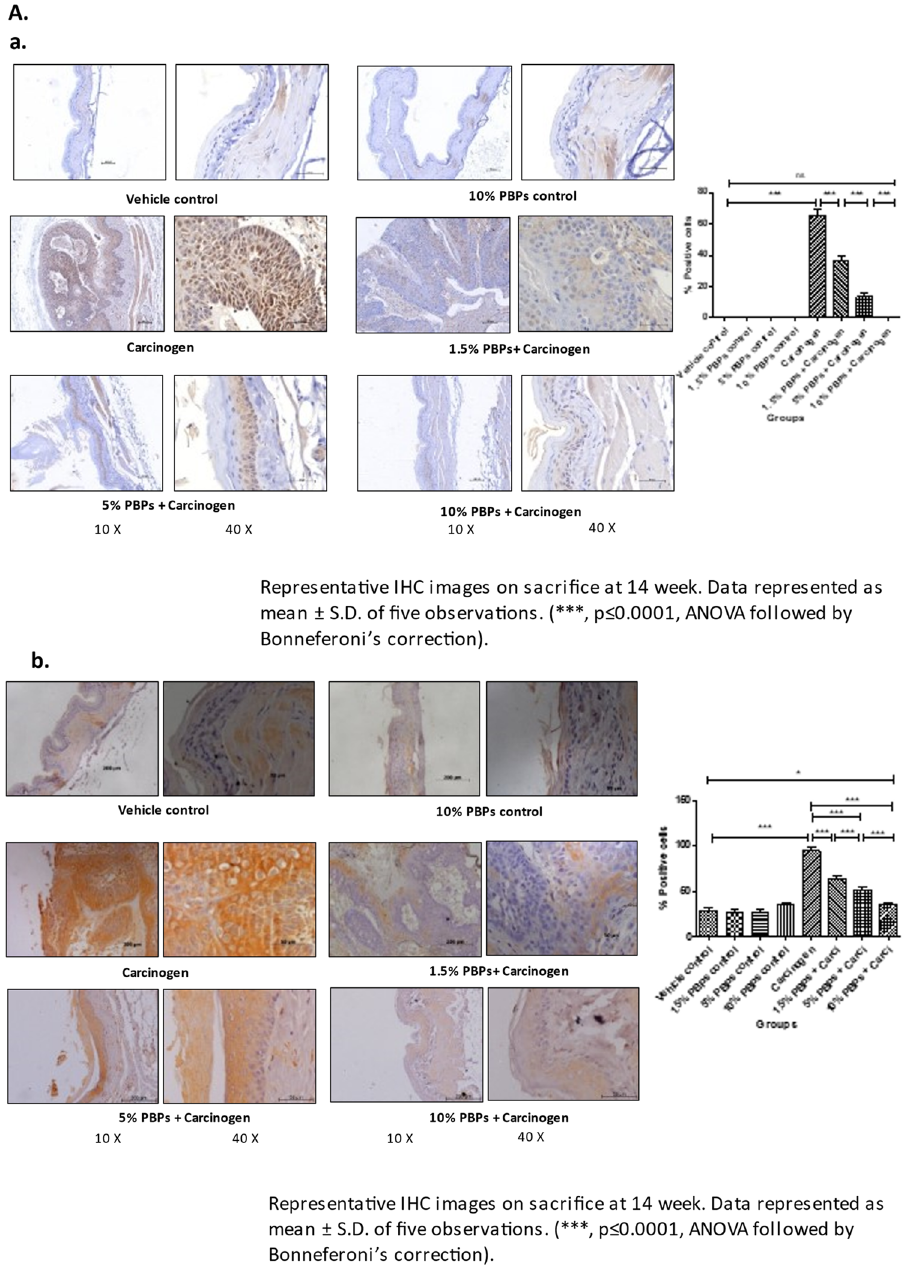
Figure 4. Effect of pre and concurrent treatment of different doses of PBPs on hypoxia and angiogenesis in experimental oral cancer. ( A ) Representative photomicrographs showing ( a ) HIF1-α and ( b ) VEGF staining. Data represented as mean ± S.D. of five observations. (***, p ≤ 0.0001, ANOVA followed by Bonneferoni’s correction). ( B ) Representative blots and relative levels of VEGF protein in buccal pouch total cell lysate. Data represented as mean ± S.D. of five observations. (***, p ≤ 0.0001, ANOVA followed by Bonneferoni’s